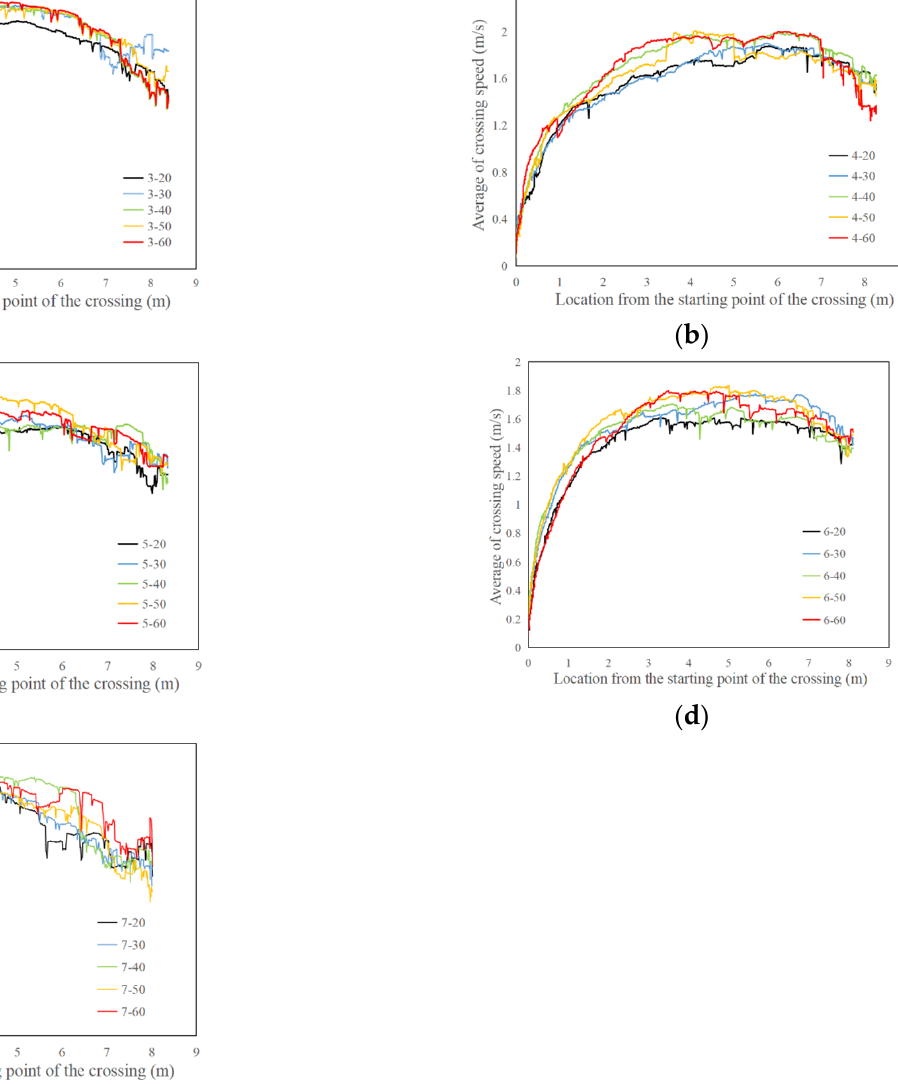
Figure 3. The continuous distribution of average crossing speed along the crosswalk. ( a ) Time headway = 3 s. ( b ) Time headway = 4 s. ( c ) Time headway = 5 s. ( d ) Time headway = 6 s. ( e ) Time headway = 7